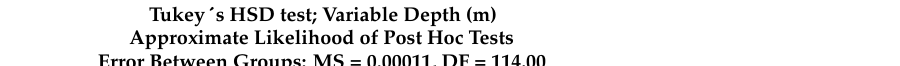
Table 8. Tukey’s test of rut depths for machines (HSM, LKT, UAT) and rut types (upper, lower). Bold indicates statistical